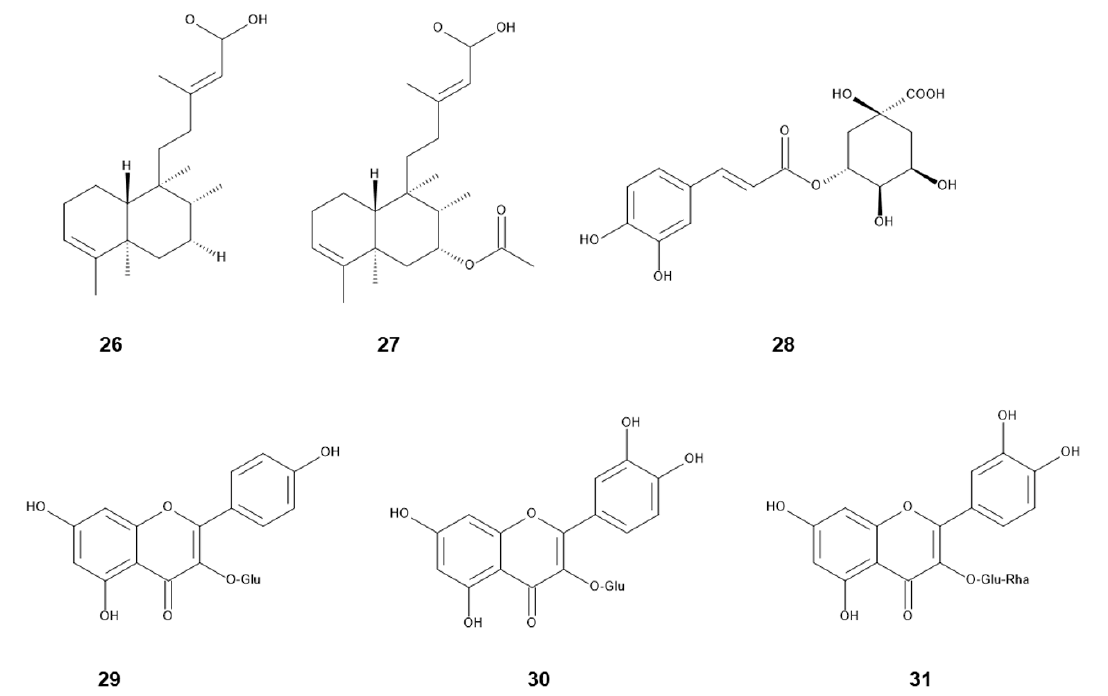
Figure 2. Allelochemicals identified in S. canadensis and S. altissima . Compound number and name were listed in Table 2.